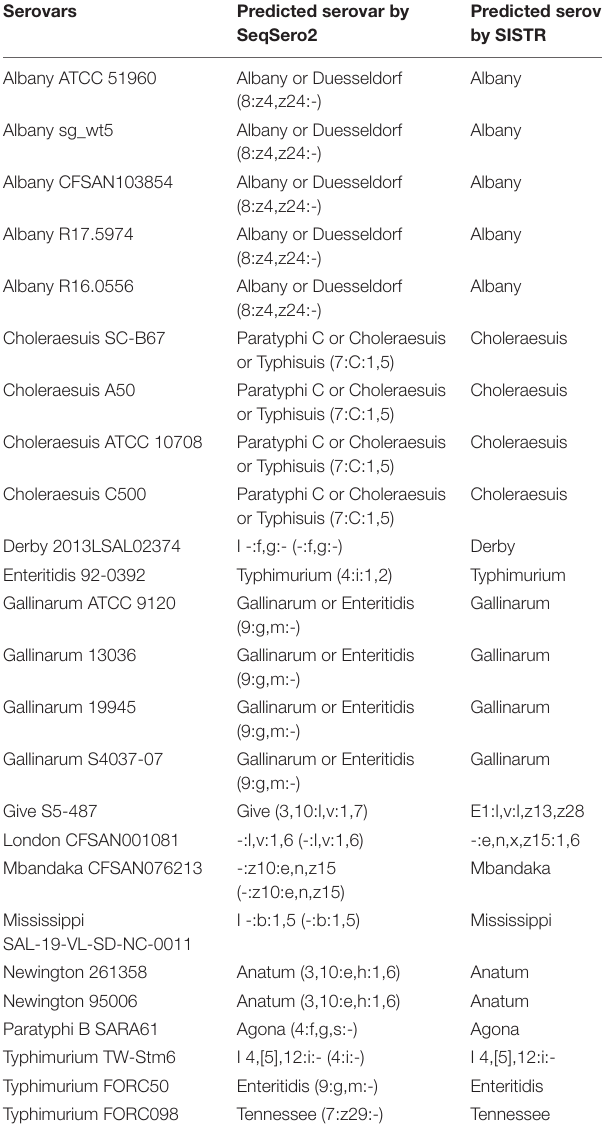
TABLE 1 | Genomes predicted to incorrect serovar among 535 Salmonella genomes by in silico